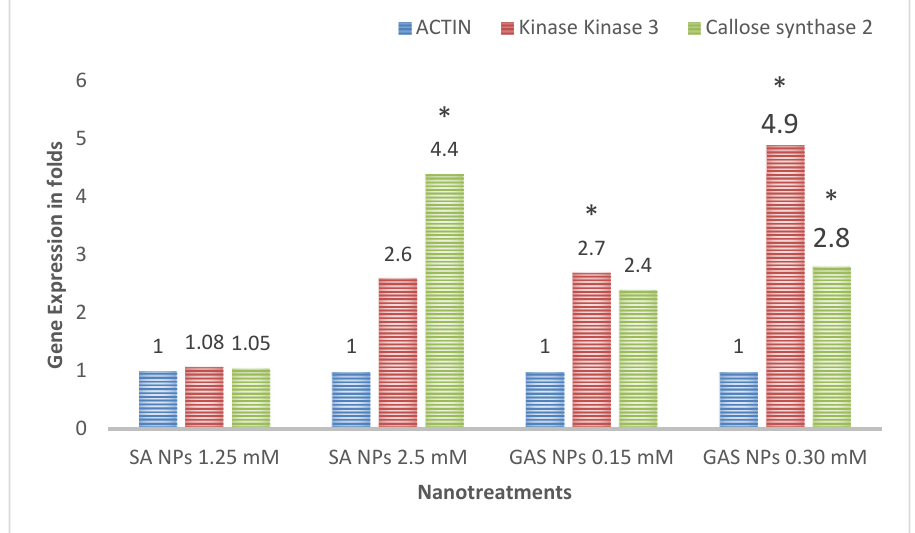
Figure 11. Expression level of Kinase Kinase 3, Callose synthase 2 and Actin reference genes in response to salicylic acid and glycyrrhizic acid ammonium salt nanoparticles. Statistically significant indicated by * p value < 0.05.